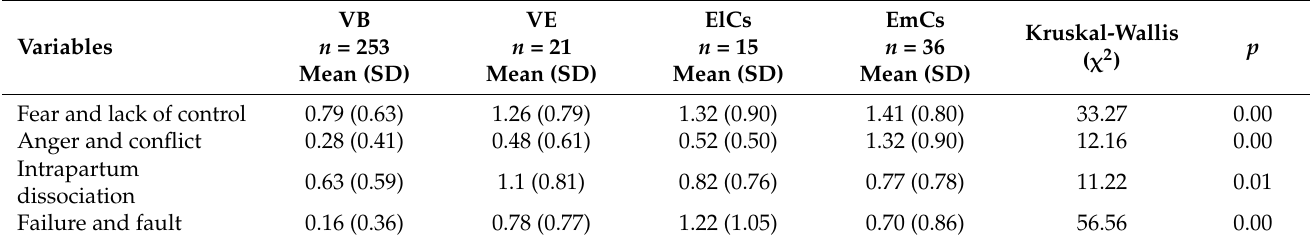
Table 4. Negative emotion differences during birth based on mode of